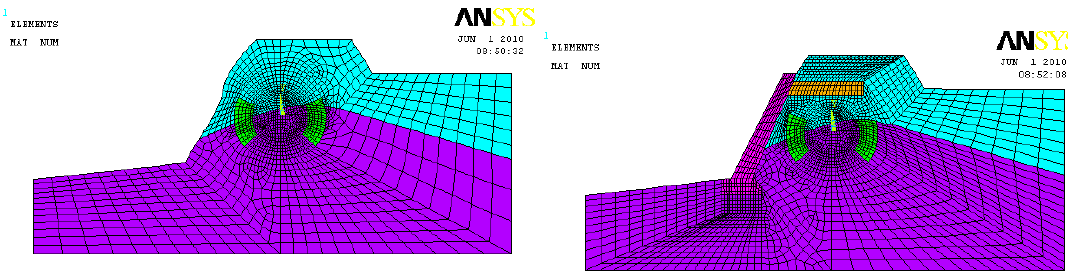
Fig. 2 Two different supporting models.